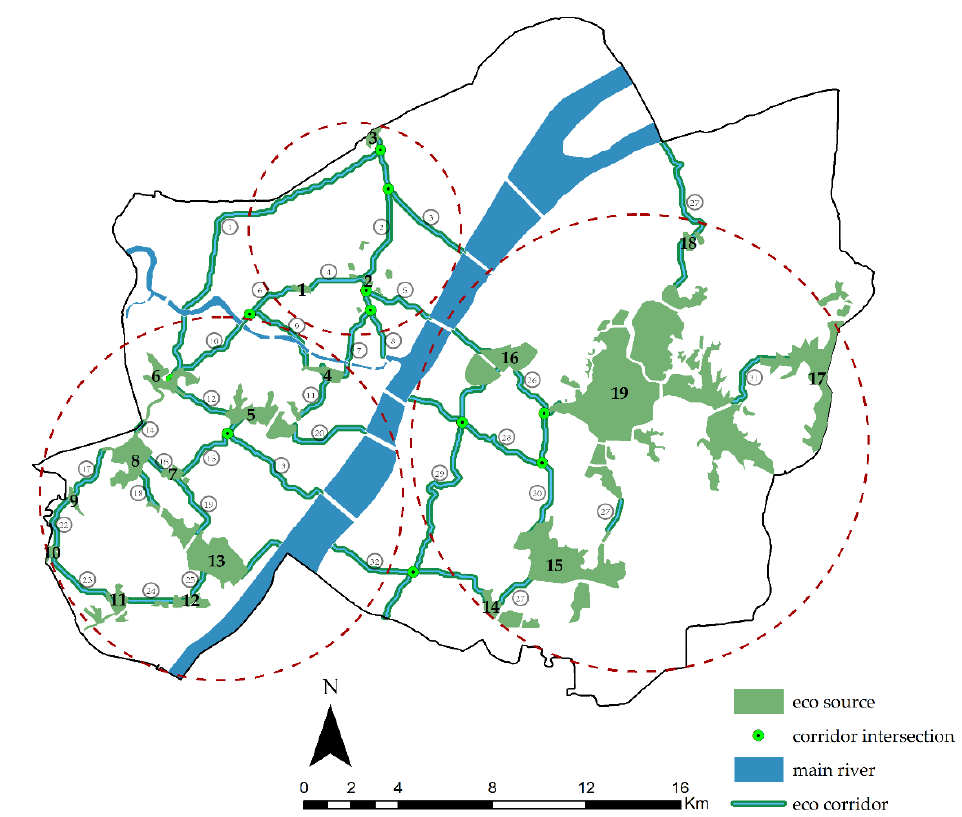
Figure 9. Distribution of ecological corridors.